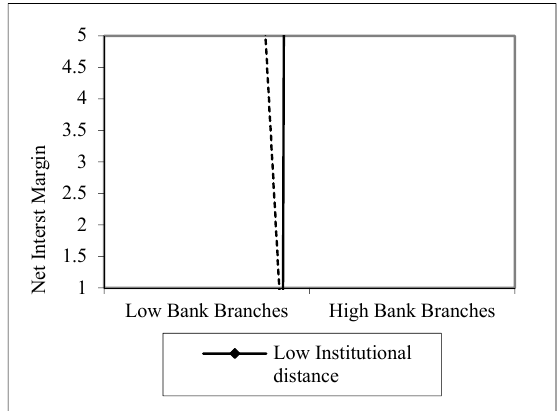
Figure 6. Bank Branch × Institutional Distance.